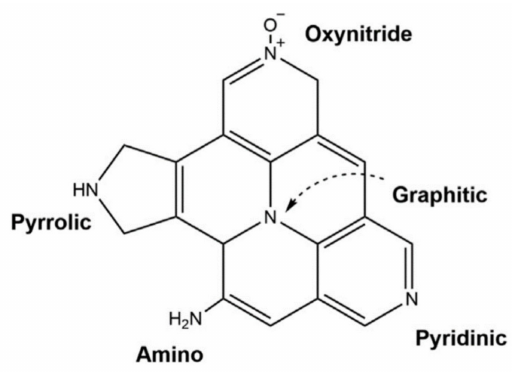
Figure 5. Main nitrogenous contents in